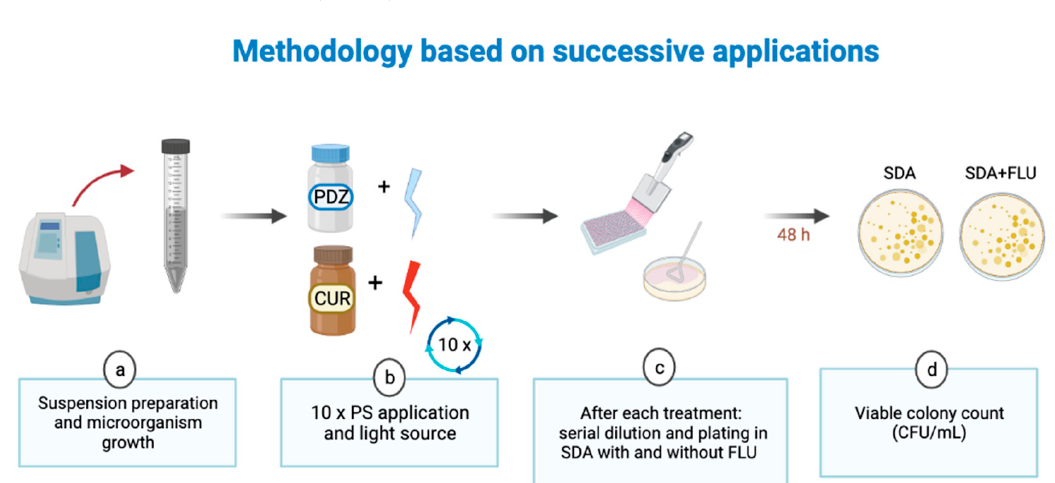
Figure 1. Flowchart of methodology based on successive applications of aPDT used in the present study.